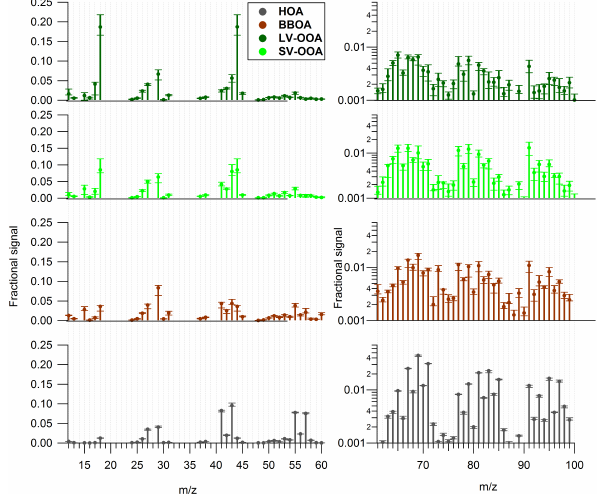
Figure 7. Mass spectral variability for the retrieved ME-2 OA sources. Median values are represented with circles and the 25th and 75th percentiles with error bars.